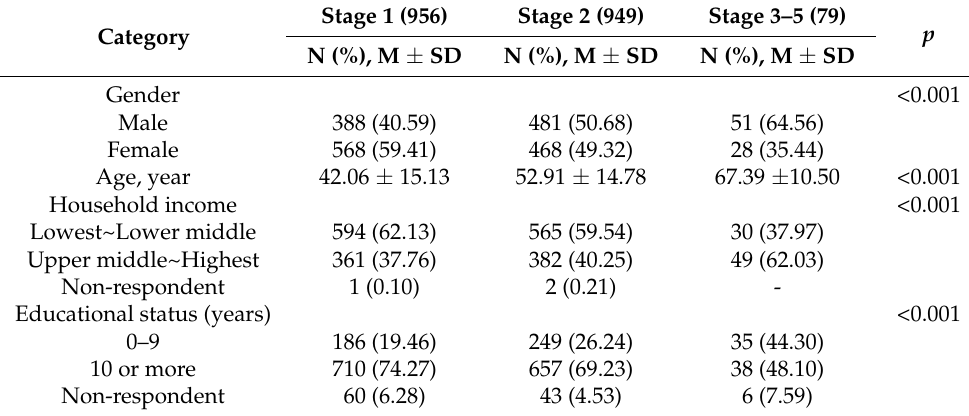
Table 2. General characteristics according to eGFR Stage (N =